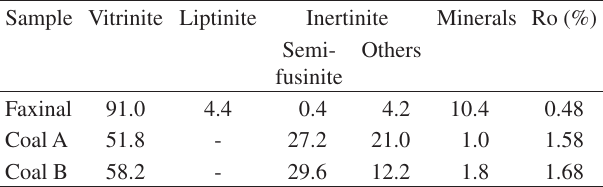
Table 4. Petrography analysis: macerals groups and vitrinite reflectance for Faxinal, A and B coals. Sample Vitrinite